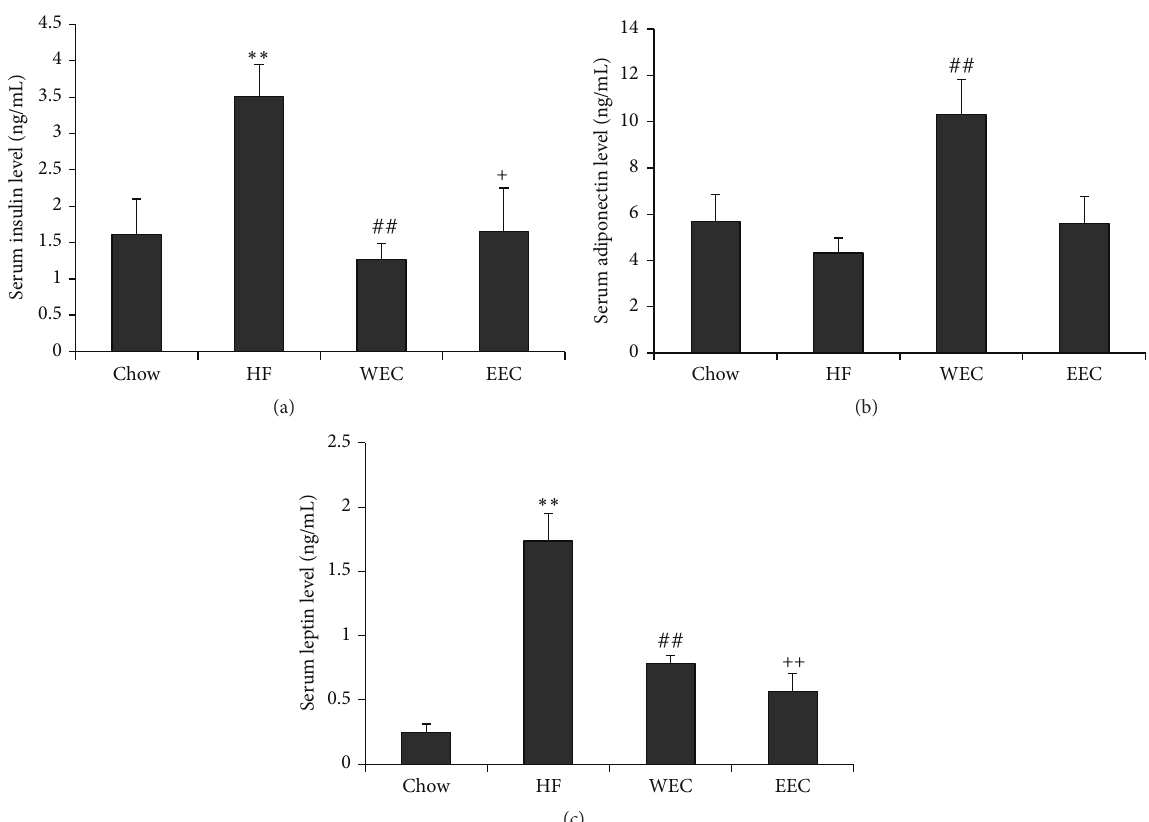
Figure 3: Effects of CTF extracts on serum insulin, adiponectin, and leptin levels. (a) Insulin; (b) adiponectin; (c) leptin. Levels in high-fat diet. The data are expressed as mean ± SEM. 𝑁 = 7 for all groups, One-way ANOVA, SPSS 21.0. ∗∗ 𝑃 < 0.01 : the Chow group versus the HF group; ## 𝑃 < 0.01 : the WEC group versus the HF group; + 𝑃 < 0.05 , ++ 𝑃 < 0.01 : the EEC group versus the HF group.